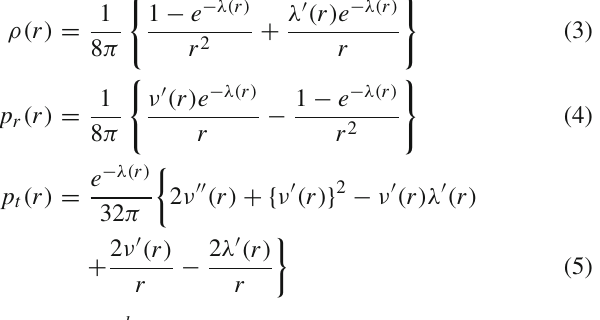
Fig. 2 Radial pressure and transverse pressure vs the radial coordinate r corresponding to numerical values of constants given in Table 2 for four well-known compact